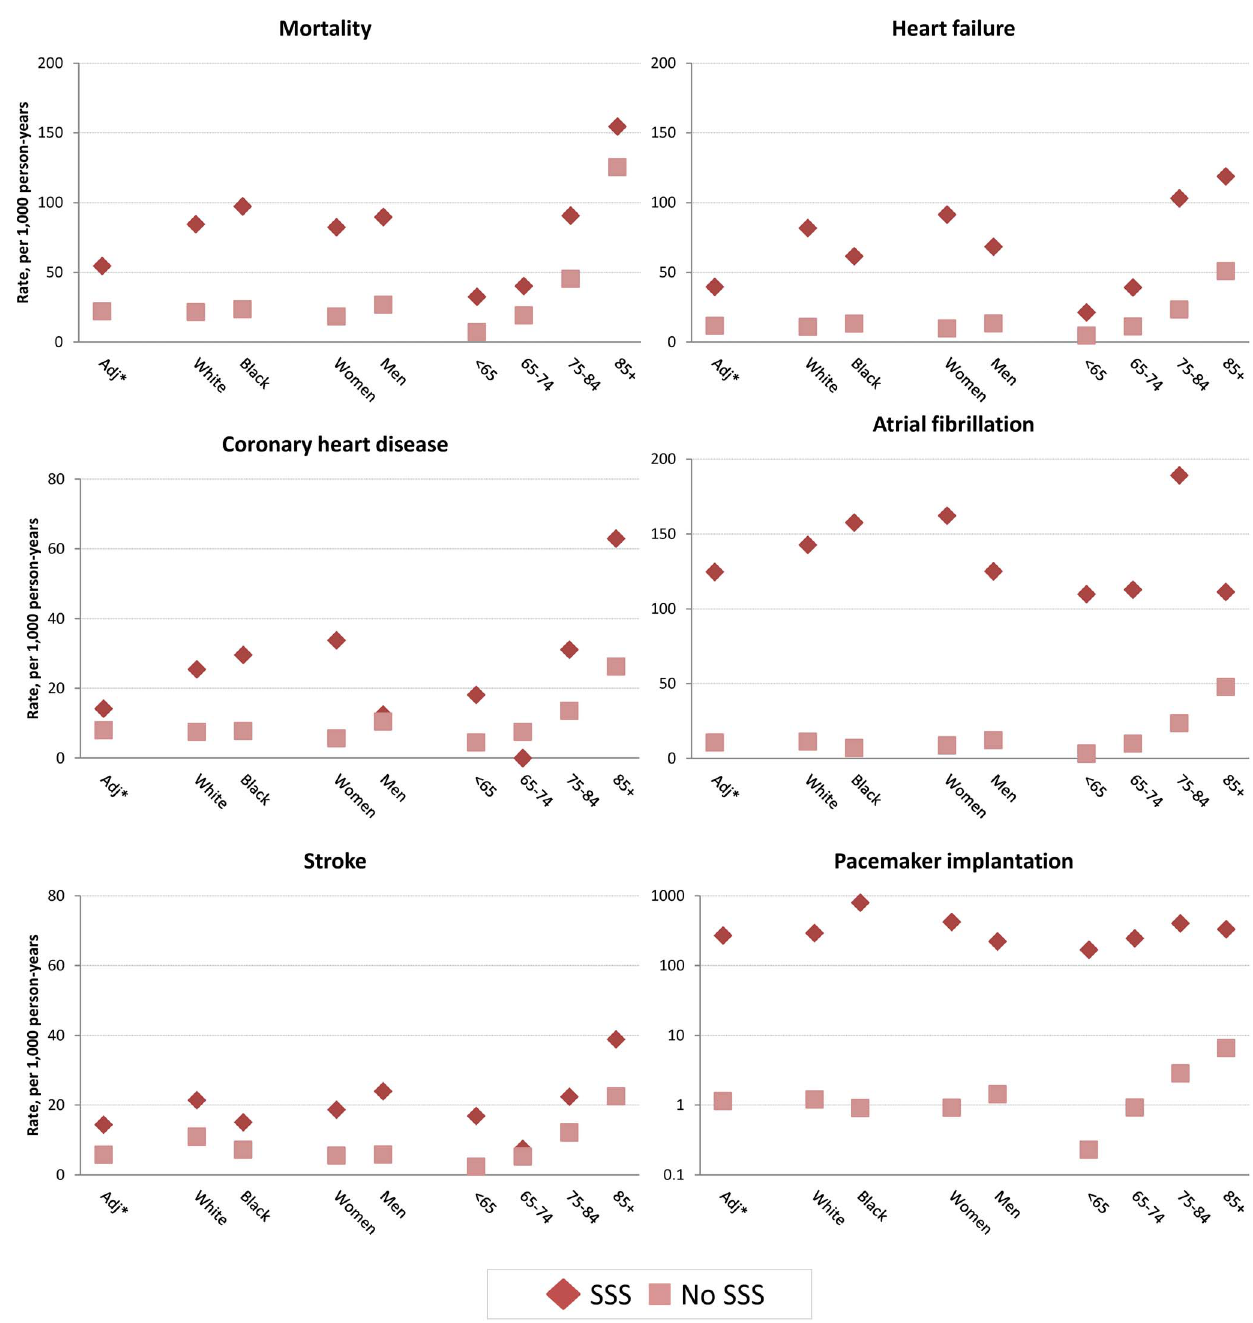
Figure 1. Incidence rates of selected cardiovascular diseases by SSS status, overall and by race, sex and age groups, combined Atherosclerosis Risk in Communities study and Cardiovascular Health Study, 1987–2009. Dark squares correspond to rates in SSS, light diamonds to rates in non SSS. Adj*: Standardized by age, sex and race to the combined ARIC and CHS person-time.